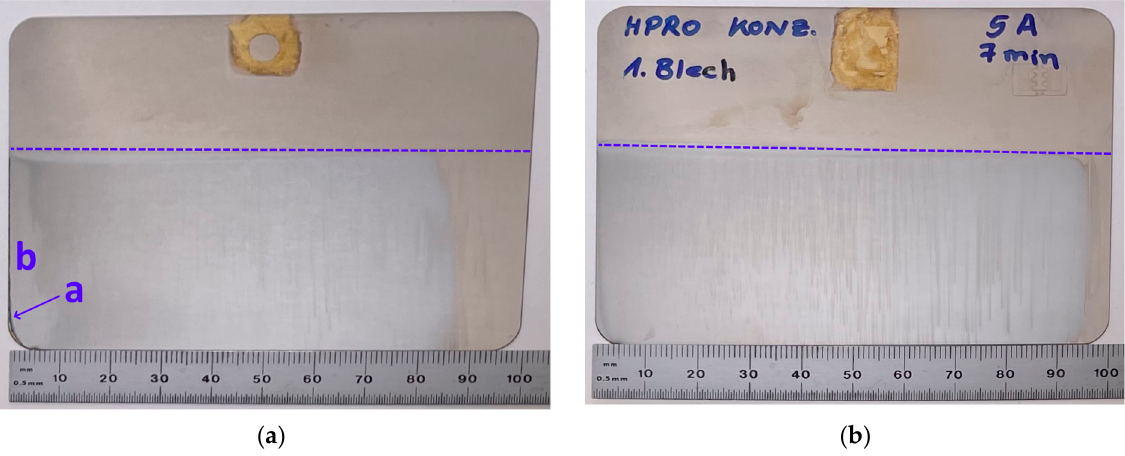
Figure 6. Hull cell test panels after coating: ( a ) Panel coated with RO concentrate without and ( b ) with further addition of plating agents. The dashed line indicates the submerged area of the